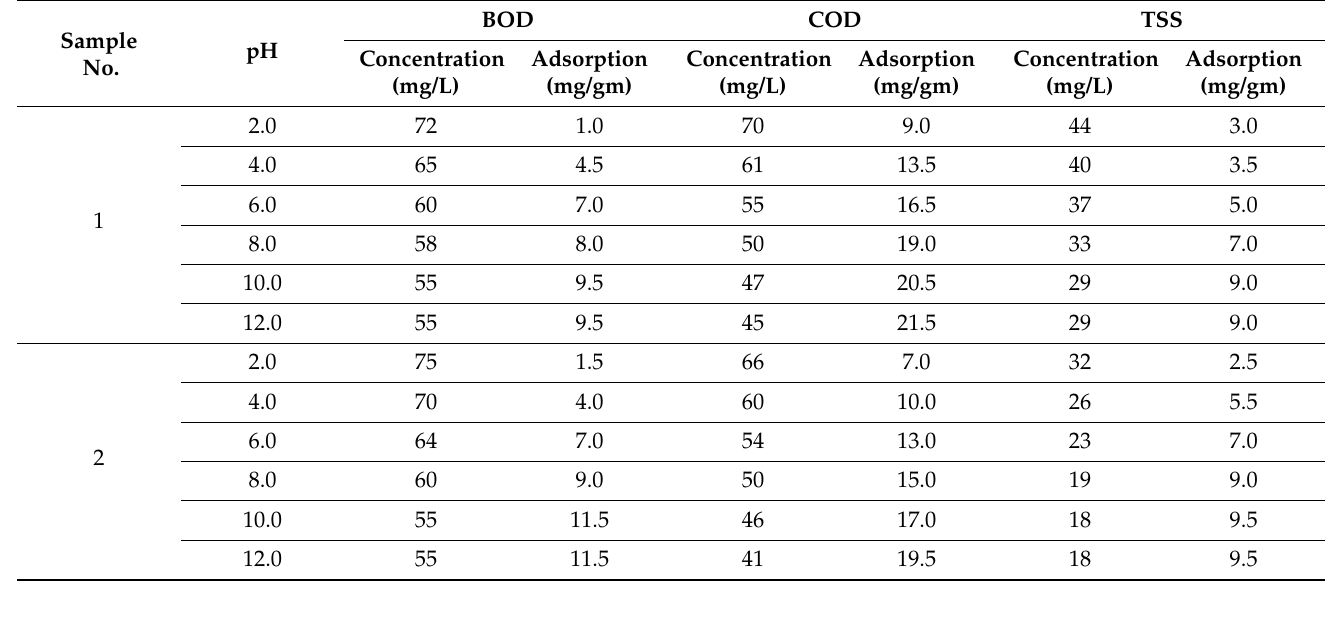
Table 4. Adsorption concentrations of BOD, COD and TSS in the industrial wastewater samples at different pH.